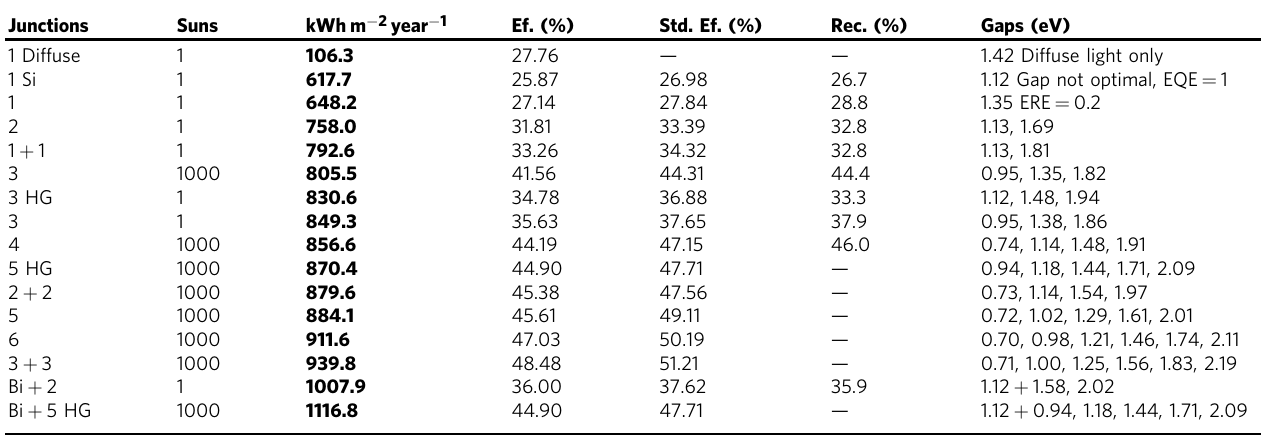
Table 1 Solar cell designs in order of increasing yearly energy yield Junctions